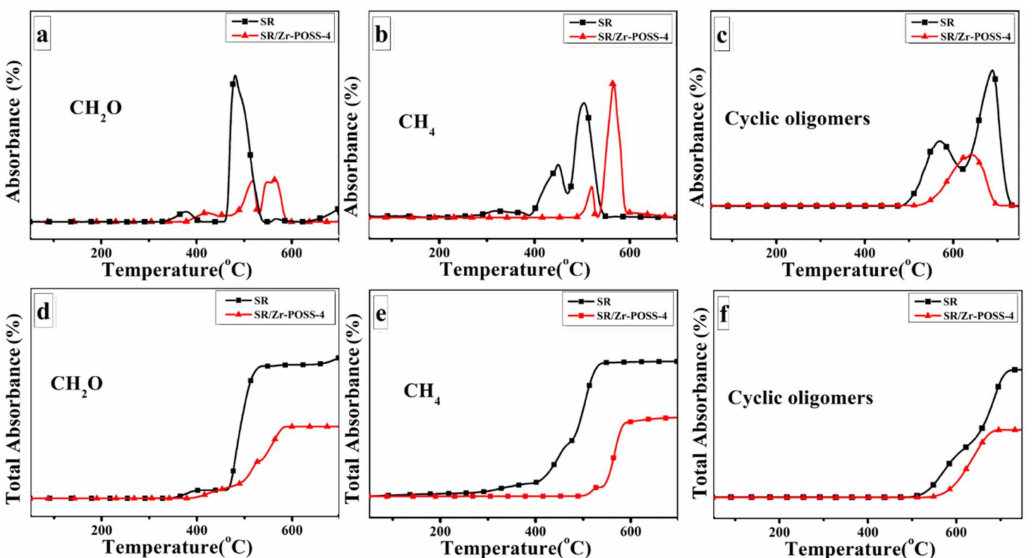
Figure 11. FTIR absorbance evolution of CH 2 O ( a ), CH 4 ( b ) and cyclic oligomers ( c ), and total absorbance of CH 2 O ( d ), CH 4 ( e ) and cyclic oligomers ( f ) during thermal degradation for SR and SR/Zr-POSS-4 under air